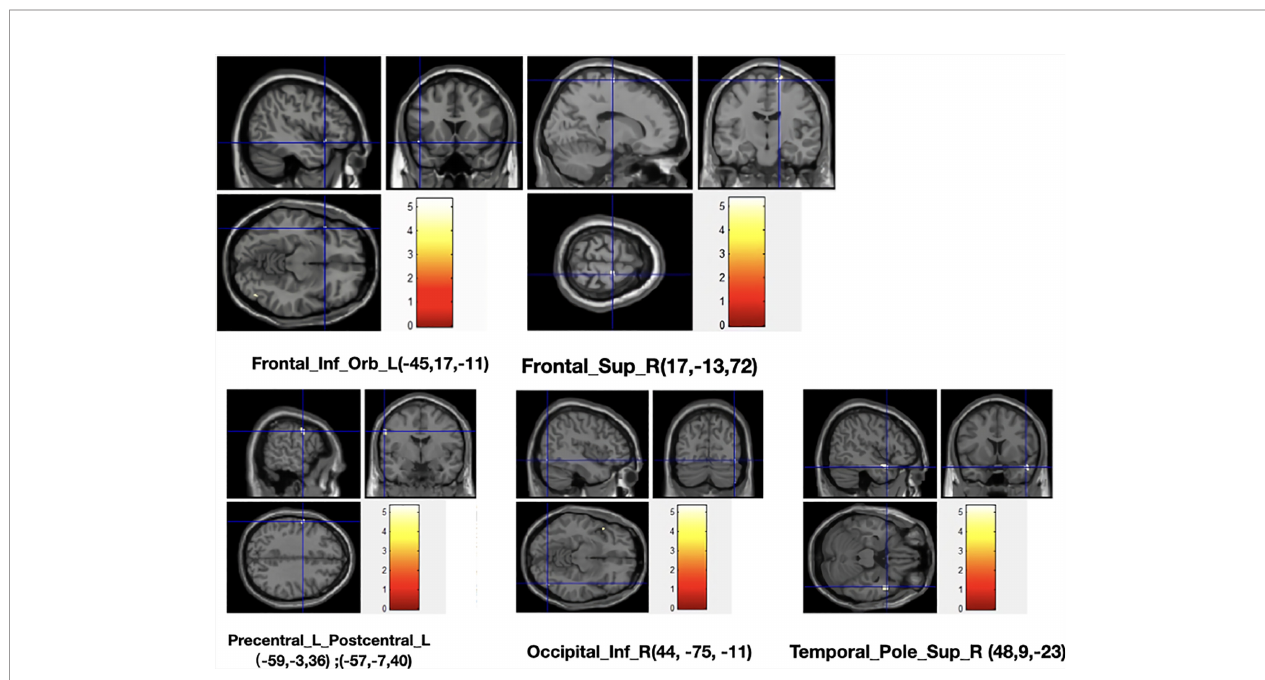
FIGURE 1 | Voxels with signi fi cant GM decrease in SCH patients compared to healthy controls.